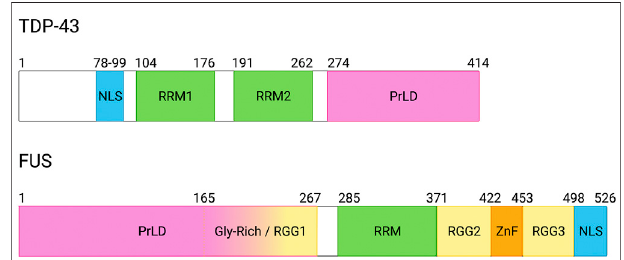
FIGURE 1 | Domain architecture of TDP-43 and FUS. TDP-43 and FUS containsimilarstructuraldomainswithsomenotabledifferences.Bothcontain a prion-like domain (PrLD), which is characterized by a high concentration of glycine, glutamine, asparagine, and tyrosine amino acids with low sequence complexity; however, the TDP-43 PrLD contains one tyrosine residue whereas the FUS PrLD is comprised of multiple tyrosines that can be phosphorylated. Additionally, the FUS PrLD overlapswith an arginine-glycine- rich (RGG) domain between residues 165 and 267. Notably, FUS contains multiple RGG domains throughout its structure in addition to a zinc- fi nger motif (ZnF). Both TDP-43 and FUS contain nuclear localization signals (NLS), although they differ in sub-classi fi cations and subsequent nuclear import receptor interactions. Both proteins also contain RNA recognition motifs (RRMs), which are important domains for RNA-binding. Created with